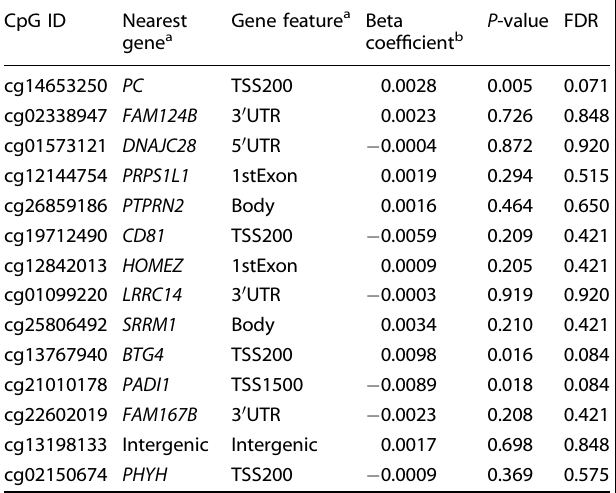
Table 3. Associations between DNA methylation in genome-wide signi fi cant DMPs and estimated risk of cardiovascular diseases (ASCVD) among